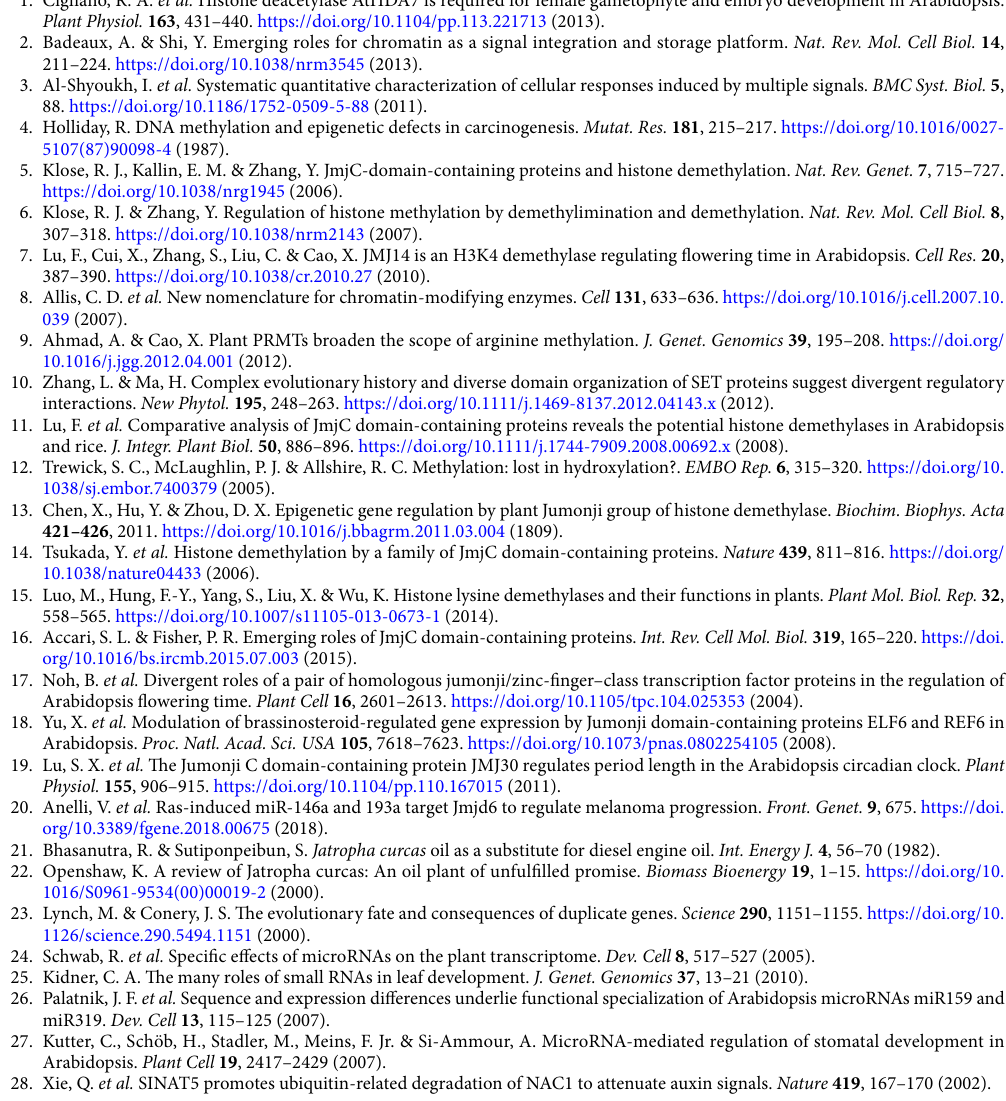
Table S4. We have integrated our pipeline using snakemake 52 . Finally, tissue and stress expression profiles of JcJMJs were generated using the pheatmap software package in the R